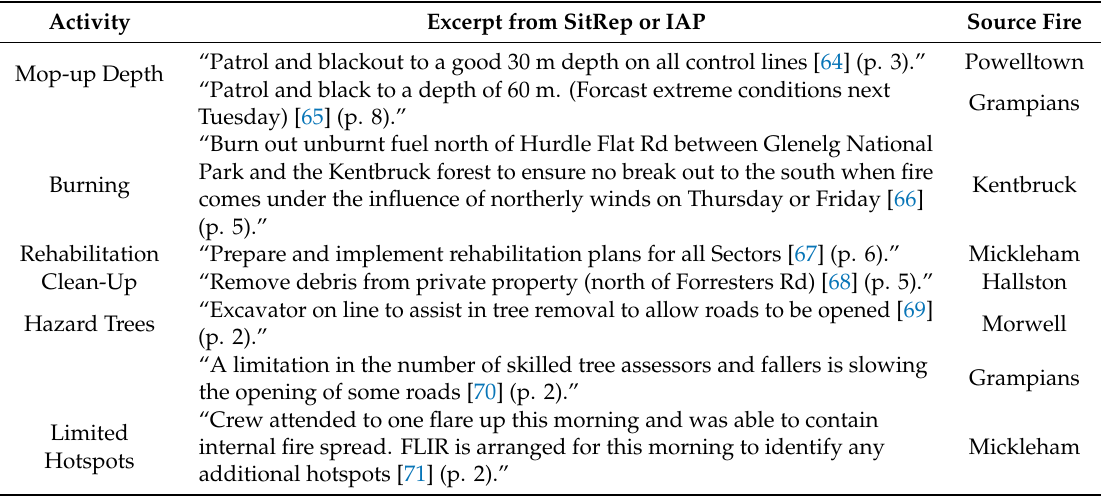
Table 6. Illustrative excerpts of suppression activities during the mop-up stage.